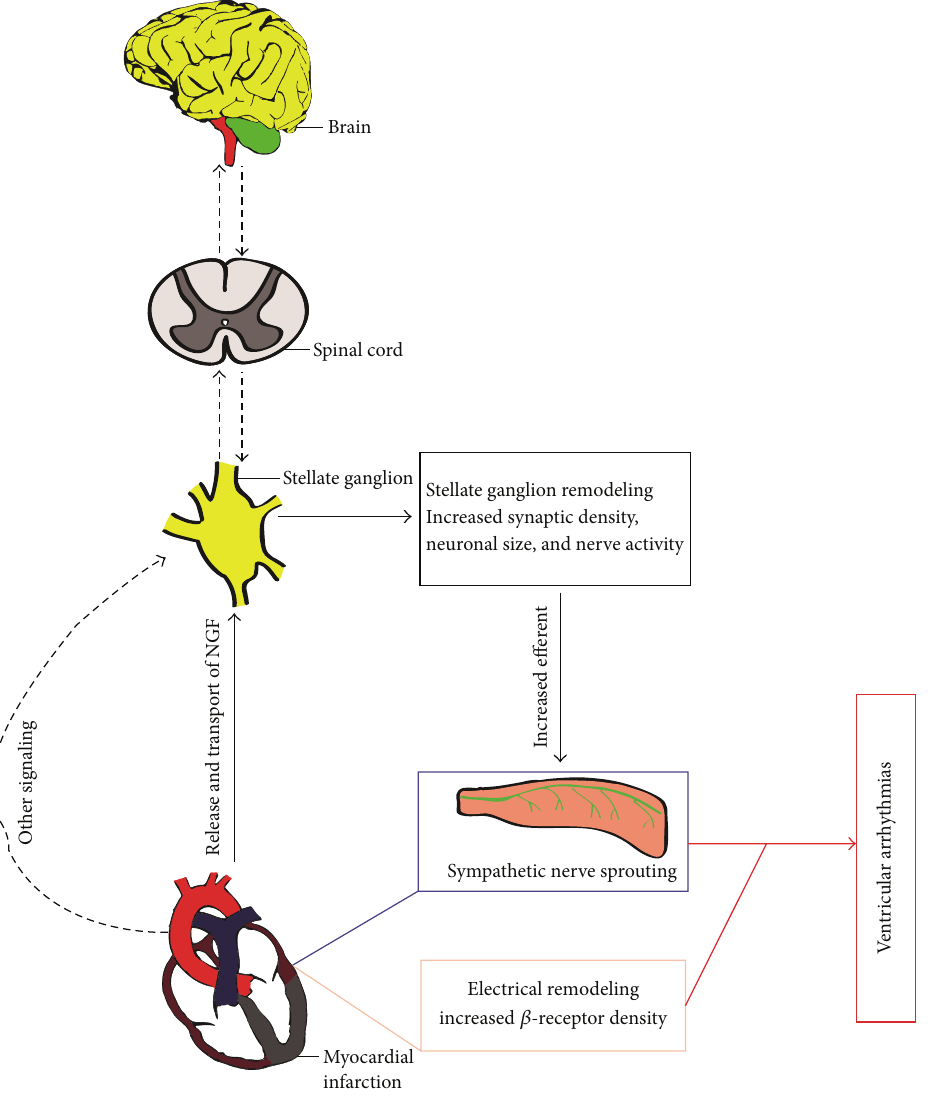
Figure 2: Sympathetic nerve remodeling increases the propensity for cardiac arrhythmias after myocardial infarction. Myocardial infarction induced NGF transported retrogradely to left (and right) stellate ganglion and other injury signals such as increased afferent nerve traffic lead to anatomic remodeling within the stellates. Increased efferent nerve signals back to the heart and promotes nerve sprout which together with electrical as well as 𝛽 -adrenergic receptor remodeling increases the propensity for malignant ventricular arrhythmias. It is not clear whether higher nervous centers also regulate this process. Solid lines represent known pathways; dotted lines represent